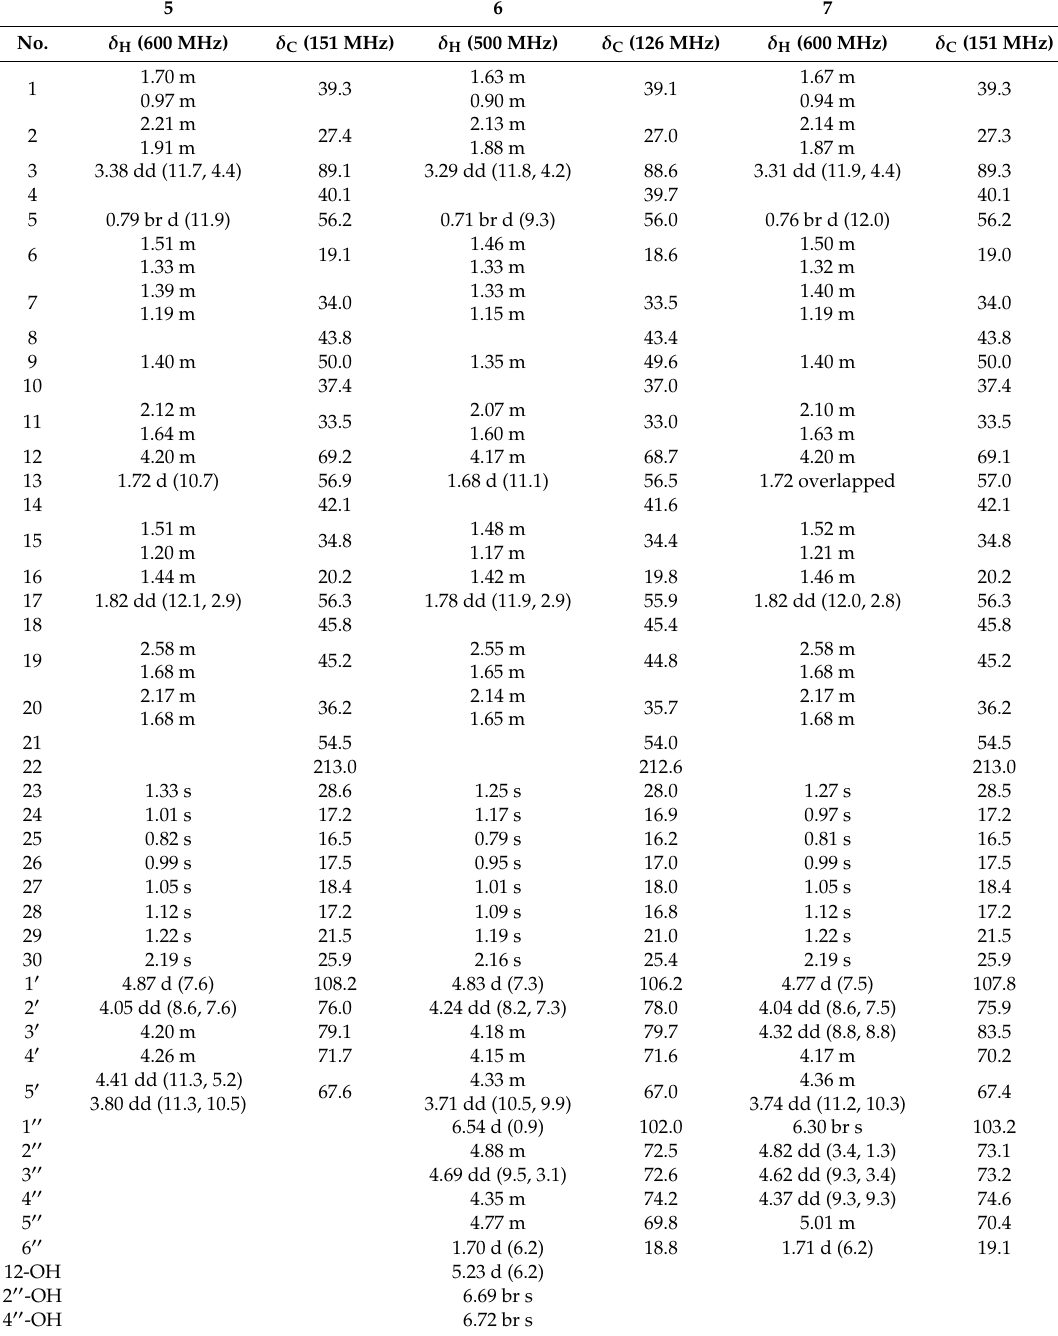
Table 3. 1 H and 13 C-NMR data of 5–7 in Pyridine- d 5 ( δ in ppm, J in